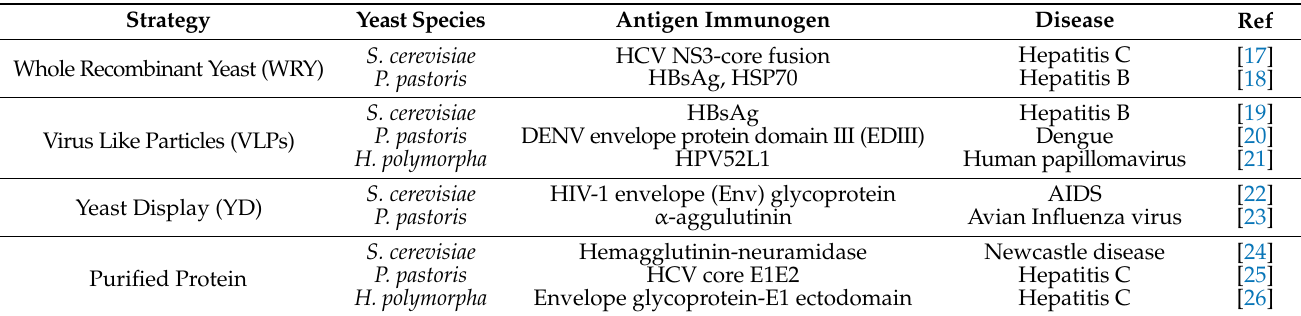
Table 3. Examples of expressed antigens against diverse clinical conditions using different yeast species and strategies in which they can be used on vaccine development.